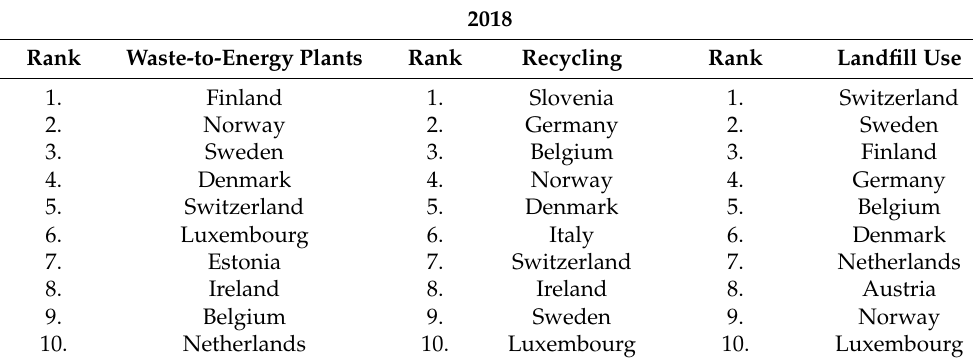
Table 3. Top 10 EU countries in 2018 by waste hierarchy.